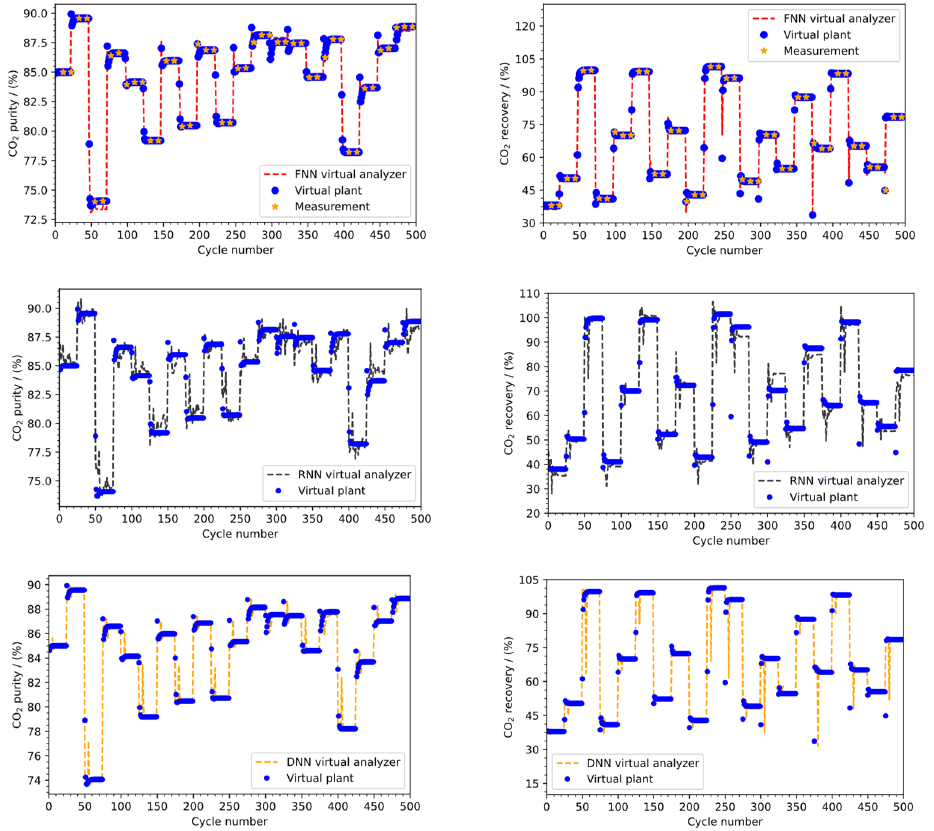
Figure 10. Soft sensors evaluation for real-time PSA recovery and purity prediction.